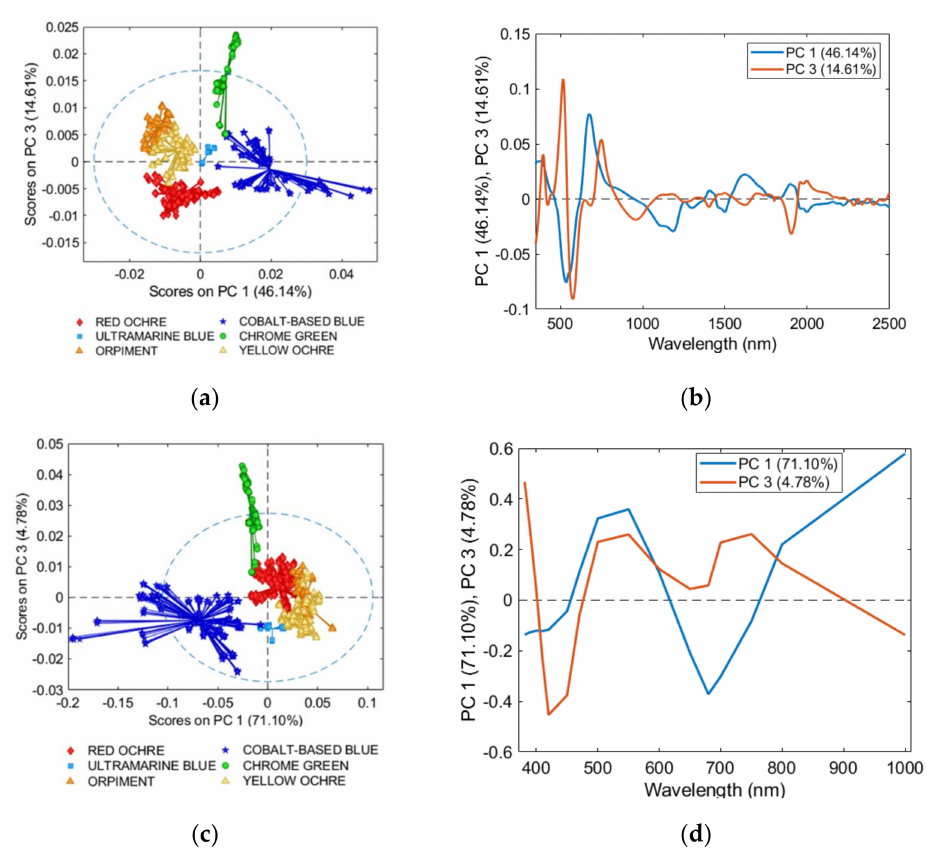
Figure 5. Score plot of PC1 and PC3 of the hyperspectral data ( a ) and relative loading plot ( b ). Score plot of PC1 and PC3 of the multispectral data ( c ) and relative loading plot ( d